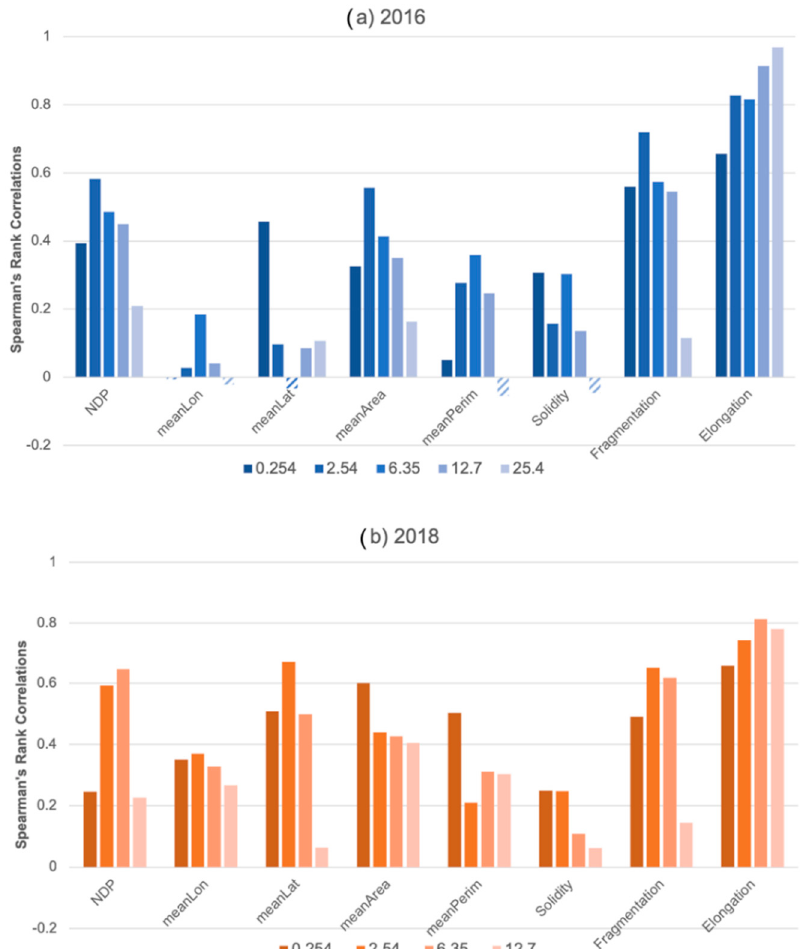
Figure 11. Spearman’s rank correlation coefficients between HRRR and Stage IV object-based metrics subset by precipitation threshold for all model cycles for the ( a ) 2016 and ( b ) 2018 case study. Correlations that do not meet a 95% confidence threshold are denoted by hatched filling.